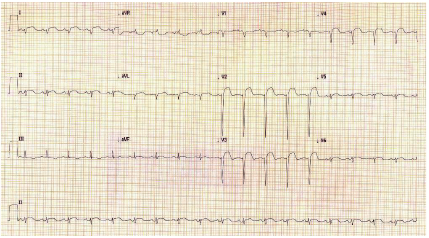
Figure 1: ECG on admission showing anterolateral ST elevation.